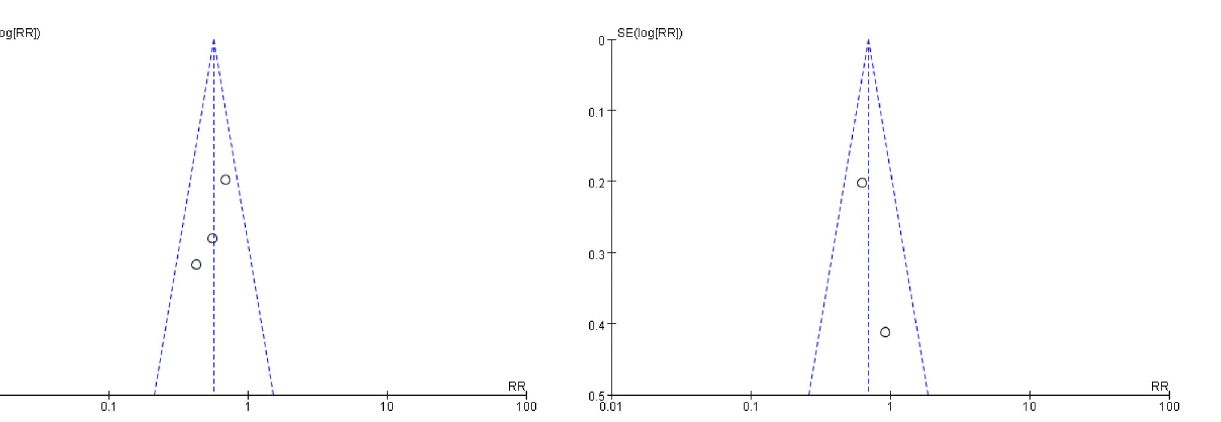
Figure 10. Funnel plot of trials of POST at 24 h after